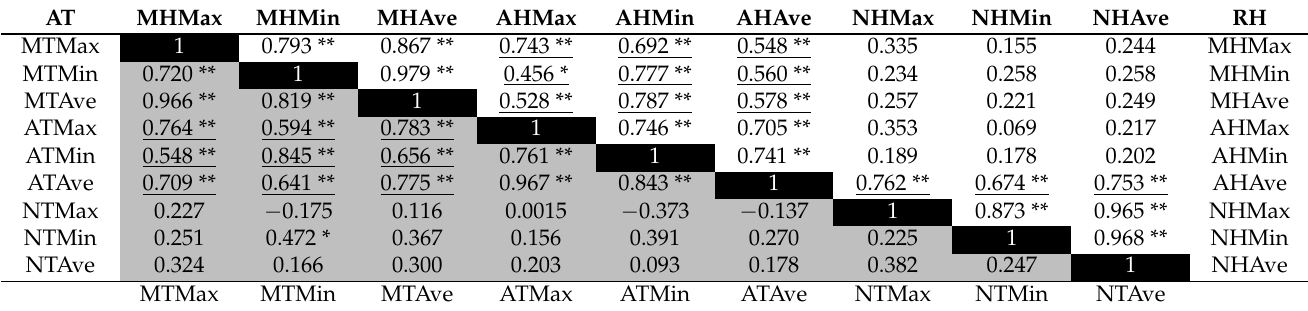
Table 7. Pearson’s correlation coefficients between air temperatures (relative humidity) at different times of day for the residential district ( n = 23).